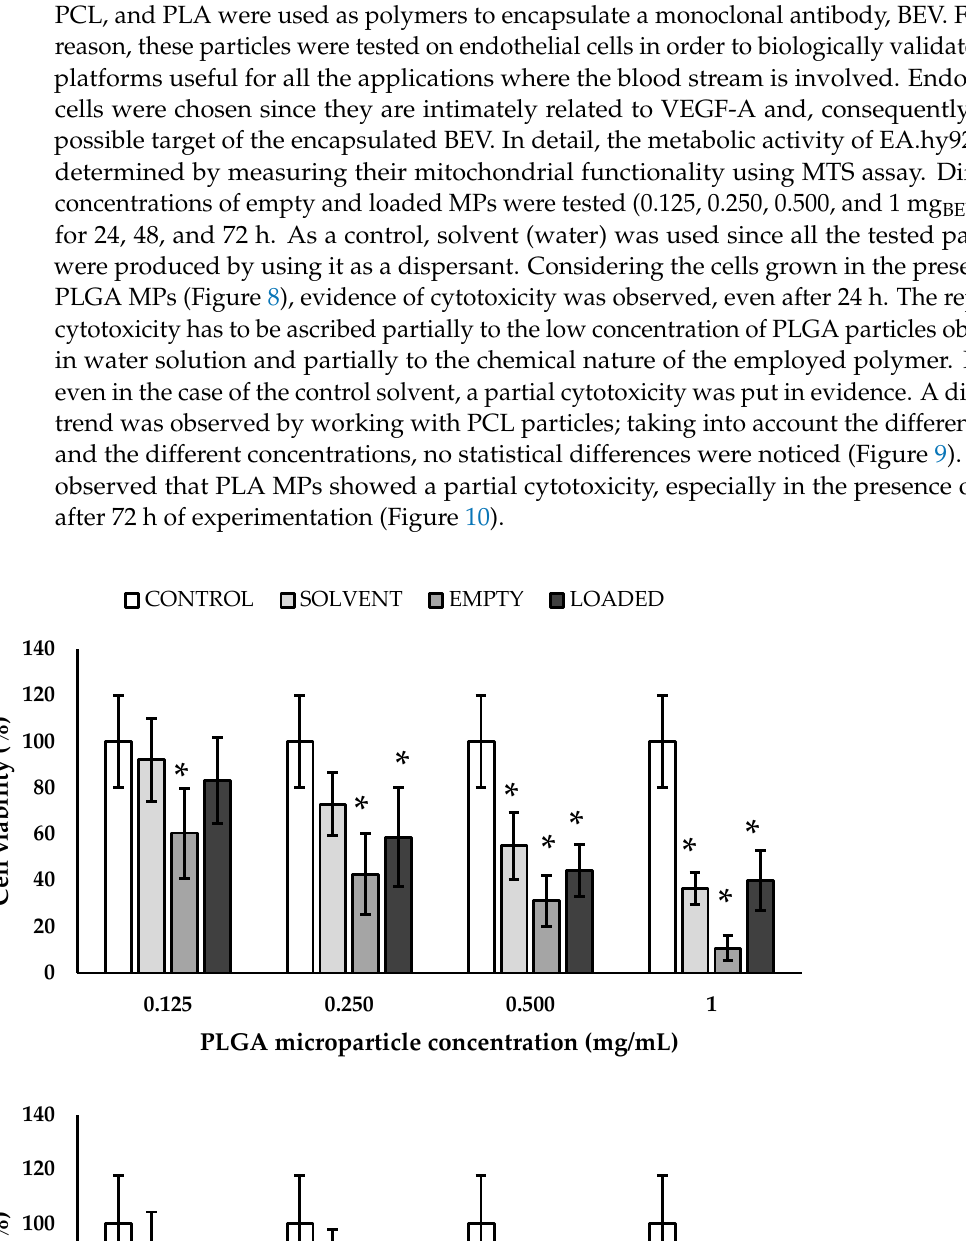
Figure 8. Cell viability of endothelial cells grown for ( A ) 24, ( B ) 48, and ( C ) 72 h in the presence of PLGA MPs, * p < 0.05 (with respect to the control using ANOVA with Tukey ’ s HSD post hoc multi- ple comparison test). PLGA: poly(lactic- co -glycolic acid). 0 20